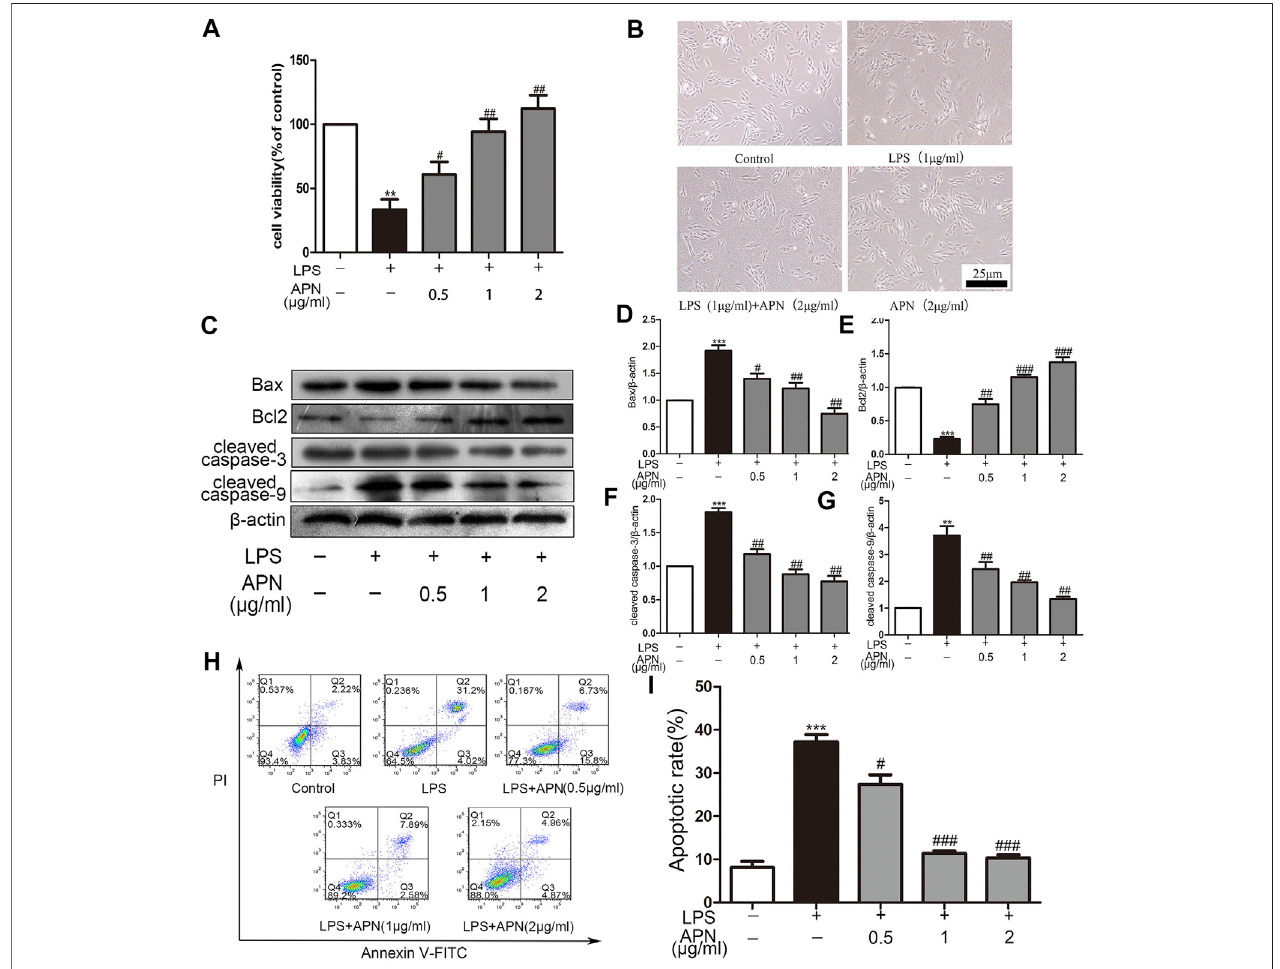
FIGURE 1 | The effects of APN on LPS-induced H9c2 cytotoxicity; cardiomyocyte apoptosis; and Bcl2, Bax, cleaved caspase-3 and cleaved caspase-9 expressioninH9c2cells. (A) APNcanreduceLPS-inducedcytotoxicity.Thecellswerepre-treatedwiththreeconcentrationsofAPN(0.5,1and2 μ g/ml)fortwohoursto assess the preservation function of APN on H9c2 cytotoxicity induced by LPS. (B) Cell morphology was observed under an inverted microscope (magni fi cation, × 40). TheCCK-8assaywasusedtodeterminecellviability. (C) LPSdownregulatedBcl2andupregulatedBax,cleavedcaspase-3andcleavedcaspase-9inH9c2cells, but these effects were attenuated by APN. (D – G) Quanti fi cation of Bax, Bcl2, cleaved caspase-3 and cleaved caspase-9 expression. (H) The apoptosis rate after treatment with APN and LPS. (I) Statistical analysis of the apoptosis rate (* p < 0.05, ** p < 0.01, *** p < 0.001 vs. control; # p < 0.05, ## p < 0.01, ### p < 0.001 vs. the LPS group. The data are shown as the means ± SEs (n (cid:2)